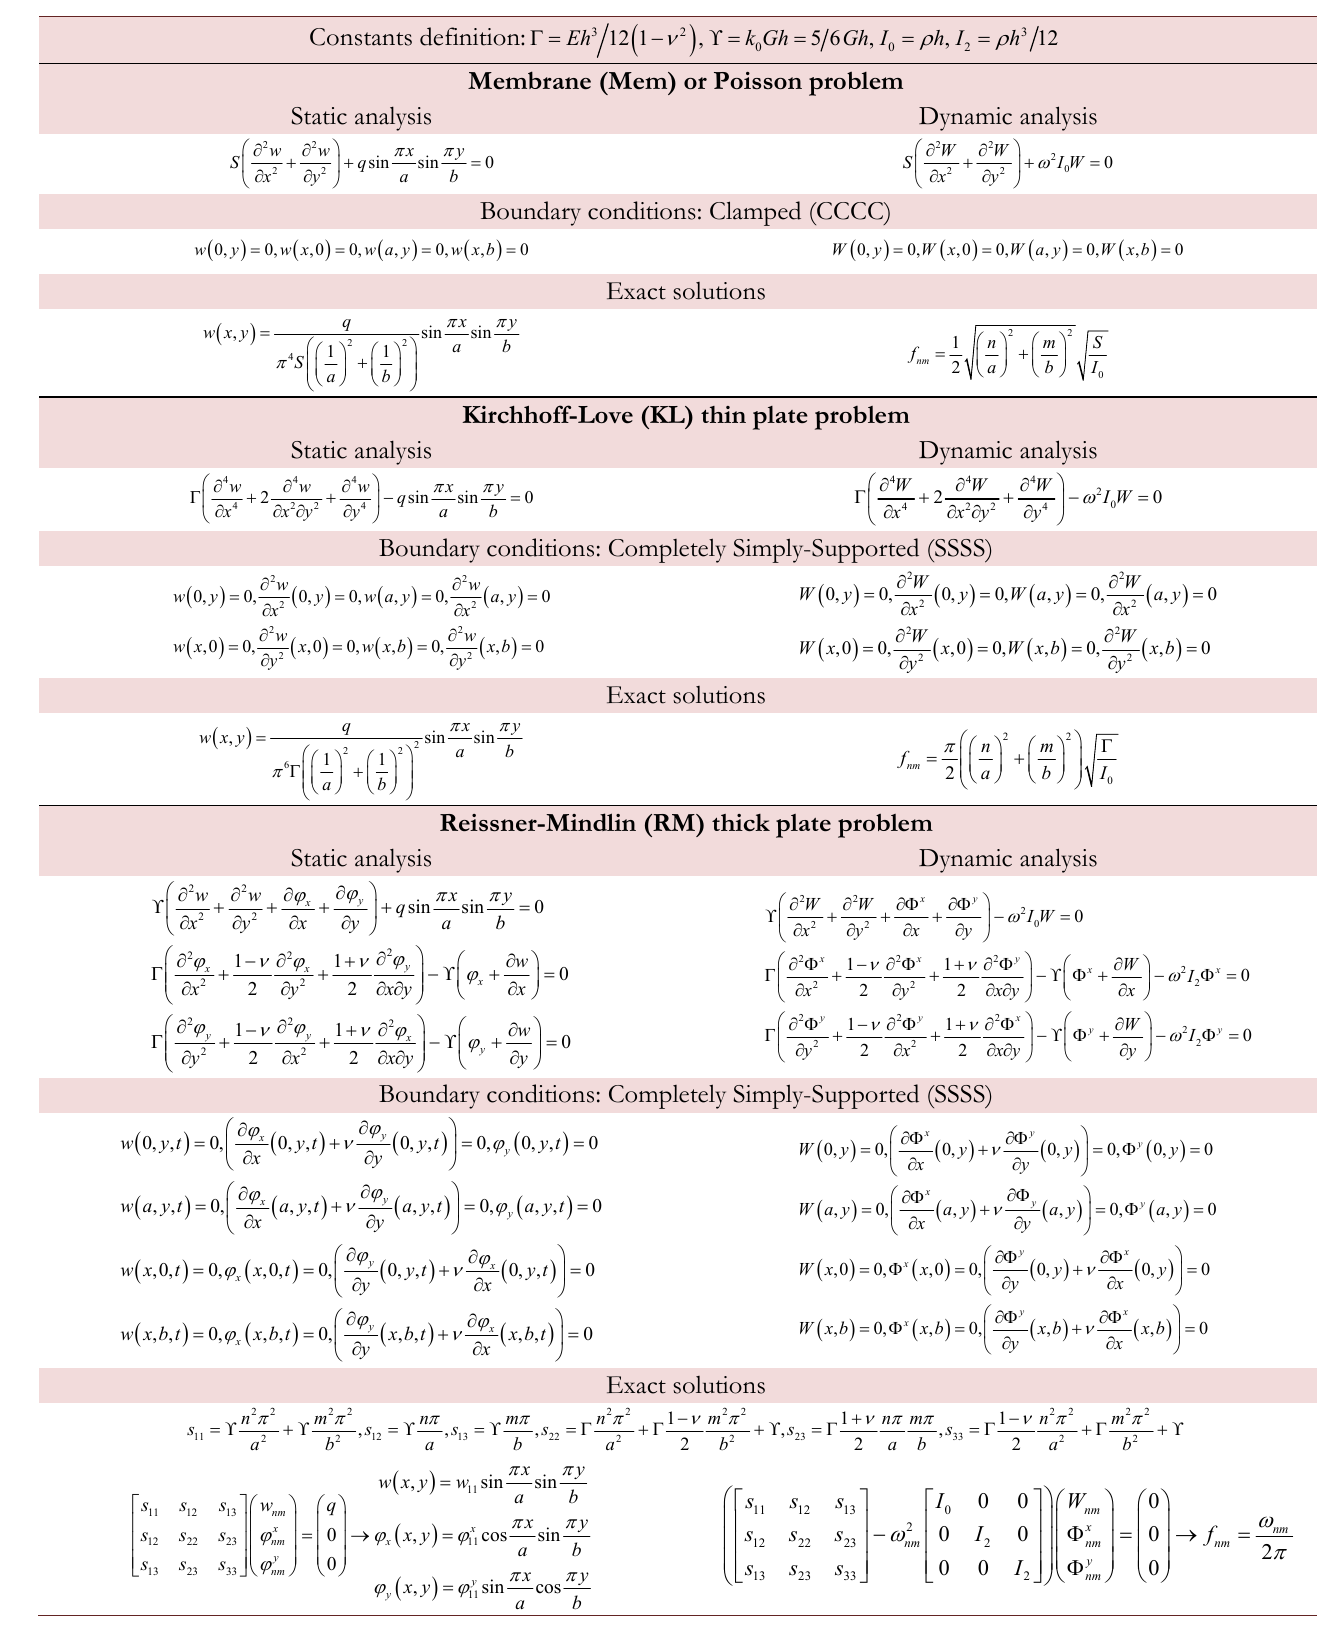
Table 4: List of two dimensional static and dynamic exact